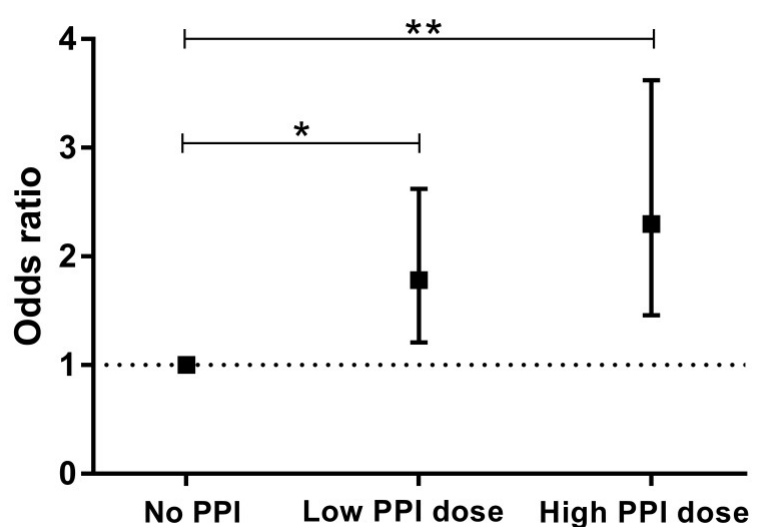
Figure 1. Crude association between PPI use and risk of iron deficiency stratified by subgroups of PPI use. No PPI, low PPI dose ( ≤ 20 mg omeprazole Eq / d), high PPI dose ( > 20 mg omeprazole Eq / d). Presented are odds ratio’s with 95% confidence intervals. ** and * represent significant p values compared to No PPI